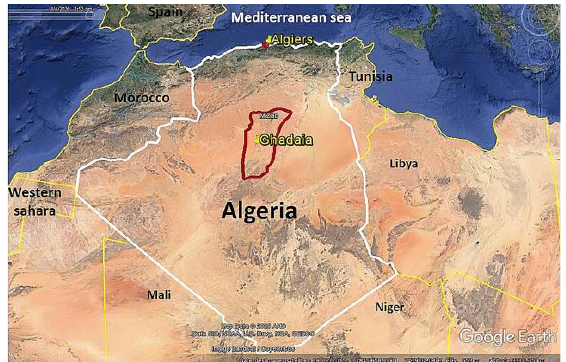
Figure 1. Location of case study sites on the map of Algeria (Google Earth, 2020 treated by the